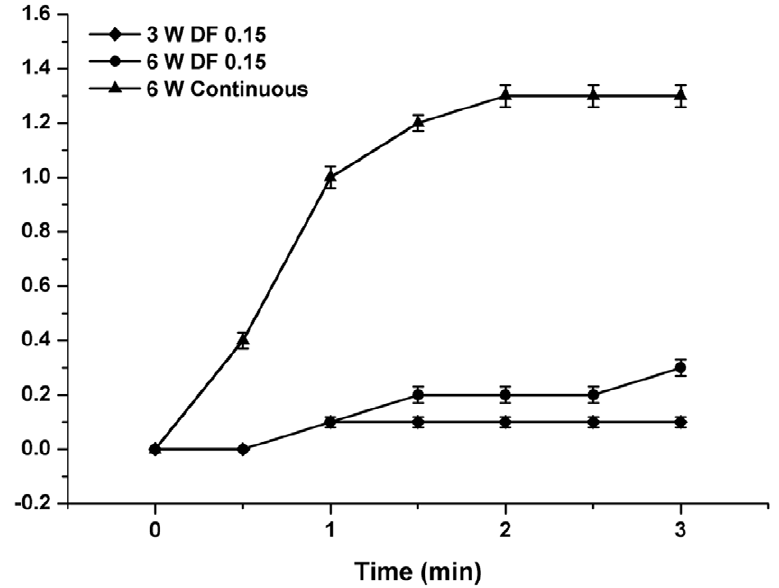
Figure 3. Measured average ultrasound-induced temperature rise vs. duration of different acoustical power and stimulation modes. Error bars (30-s intervals) show the standard deviation between the different measurements. Temperature was measured with a thermocouple probe immersed in the culture medium.